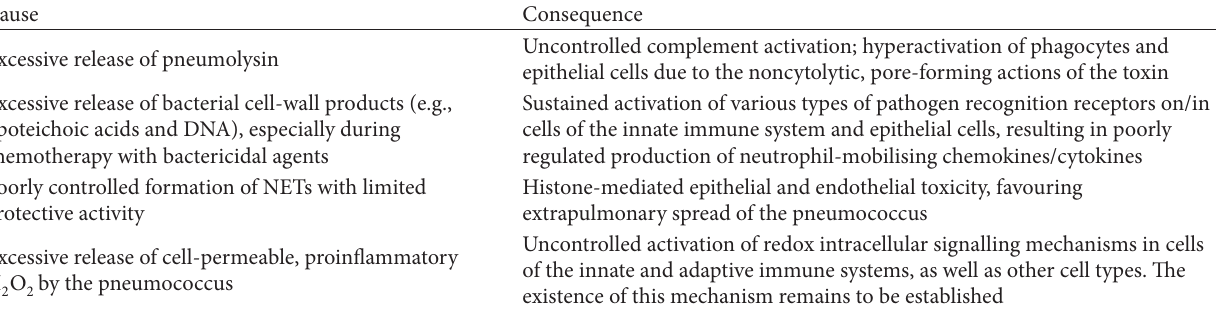
Table 2: Causes of overexuberant inflammatory responses during pneumococcal